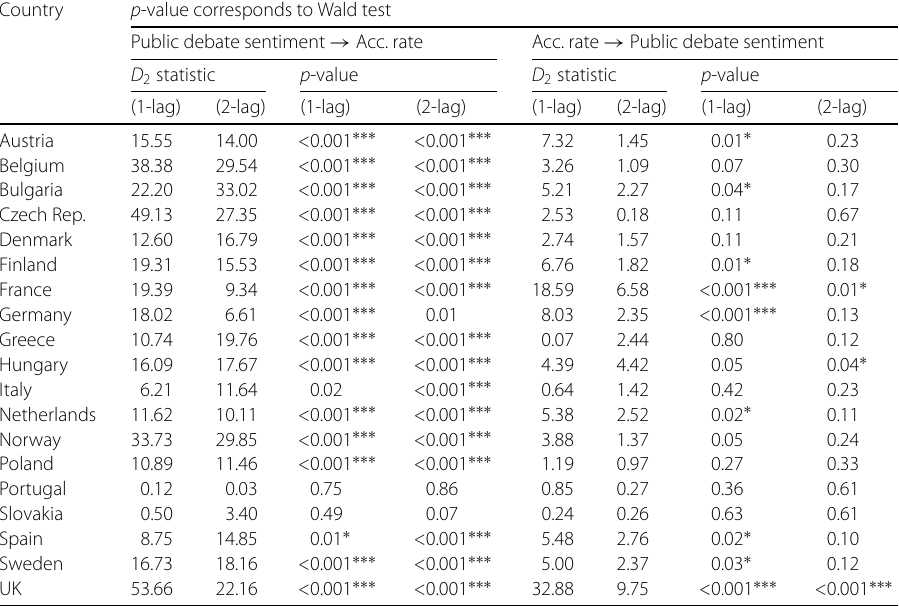
Table 4 Granger-causality test results with alternative specifications. Granger-causality test of interactions between asylum acceptance rates and public debate sentiment in the media. The 20 asylum seekers’ countries of origin with the most decisions made (both accepted and rejected) are included in the regressions. We report Granger-causal testing for 1-month (1-lag) and 2-month (2-lag) lagged VAR models. Locations with NA result from monthly data not being available from the EU database. The D 2 statistic is computed as in [71] and is the result of combining Granger tests from multiply imputed datasets Country p -value corresponds to Wald test Public debate sentiment → Acc. rate Acc. rate → Public debate sentiment